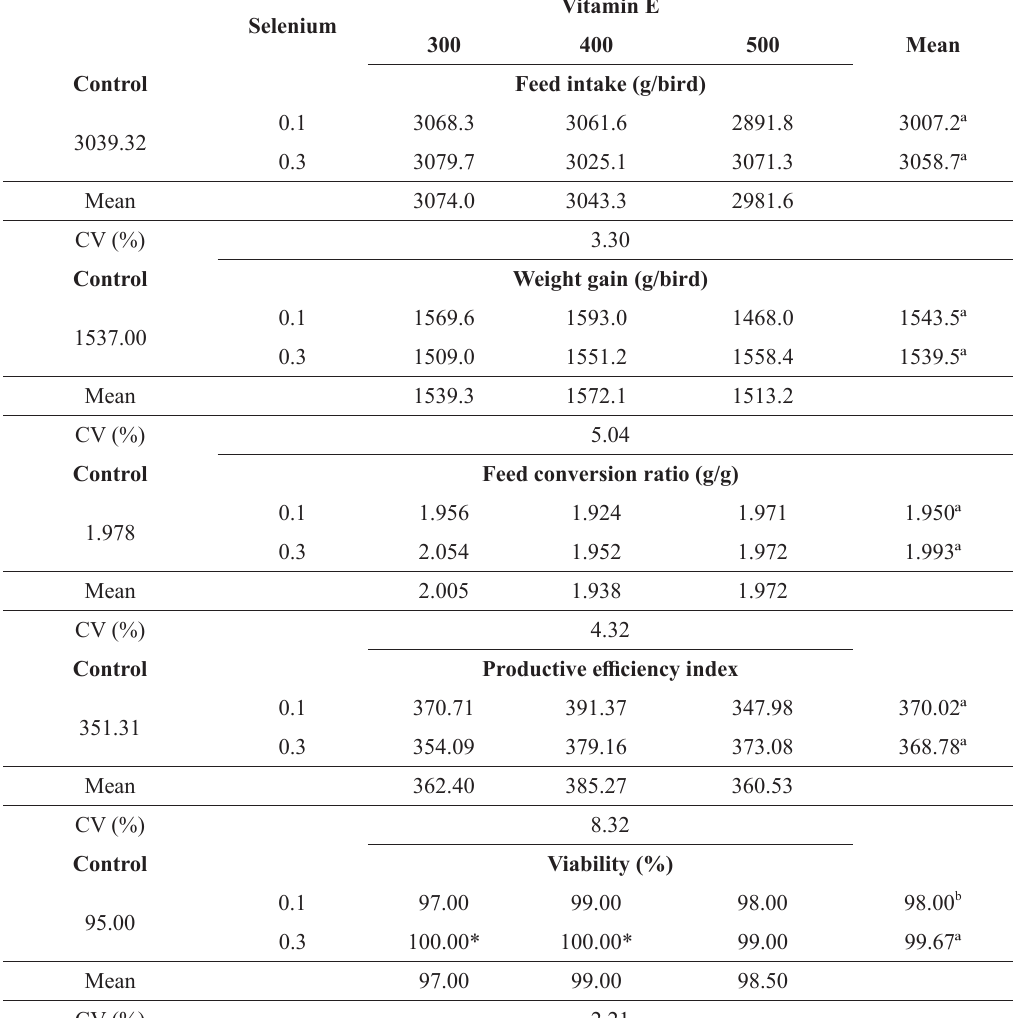
Performance of broilers from 22 to 42 days old fed different levels of selenium and vitamin